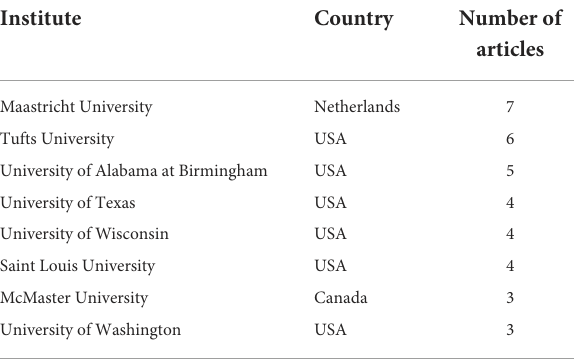
TABLE 3 Institutes that contributed more or equal to three